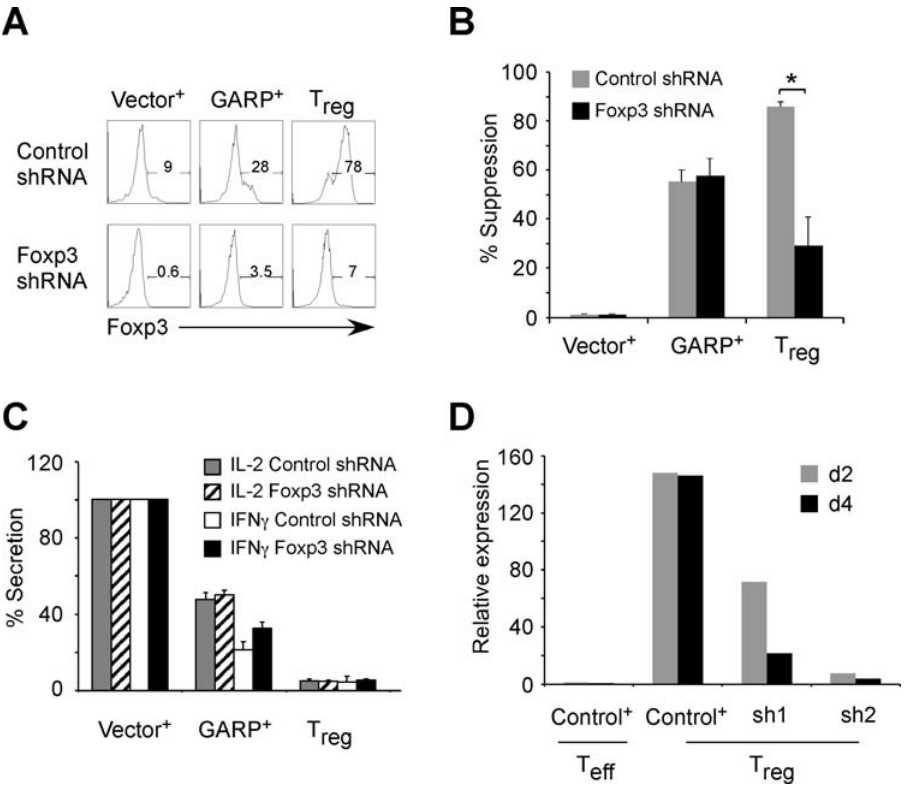
Figure 4. GARP functions as a downstream effector molecule of Foxp3 expression. ( A ) Efficient knockdown of Foxp3 expression in GARP- transduced and T reg cells. T N cells were co-infected with shRNA-expressing HDV (GFP) and control or GARP-expressing HDV (RFP), while T regs from the same donor were transduced with shRNA-expressing HDV. Cells were cultured for two weeks before staining for CD25 and CD62L, and before sorting for experimental lines: GFP + RFP + for control vector or GARP-expressing cells; GFP + for T regs . Foxp3 was stained after re-stimulation by DC and SEB. Vector + , control vector-transduced T N cells; GARP + , GARP-transduced T N cells; T eff , expanded T N cells. ( B ) Suppressive activity and ( C ) cytokine profiles of Foxp3 shRNA-expressing GARP-transduced and in vitro expanded T reg cells. Data represent the mean 6 SEM of experiments from three different donors. Cytokine data are shown by first normalizing the control to be 100%. Range of control production (pg/ml): IL-2, 300–1000; IFN c , 3000–10000. *, P , 0.05, n $ 3; experimental versus control. ( D ) GARP level in in vitro expanded T reg cells was decreased by silencing Foxp3 as determined by qPCR analysis day 2 or day 4 post TCR stimulation. d, day. Two different shRNA oligos against Foxp3 were tested, both of which have been described